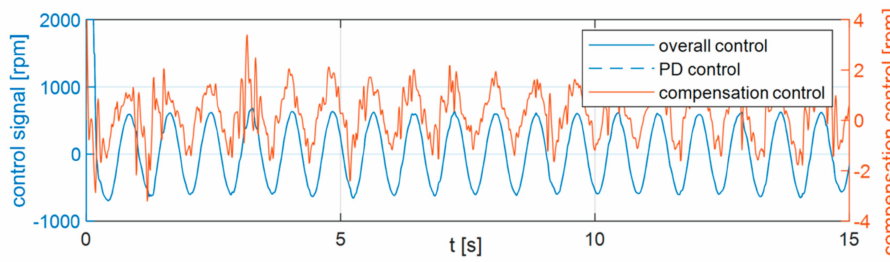
Figure 20. Signals of overall control and control signal components as functions of